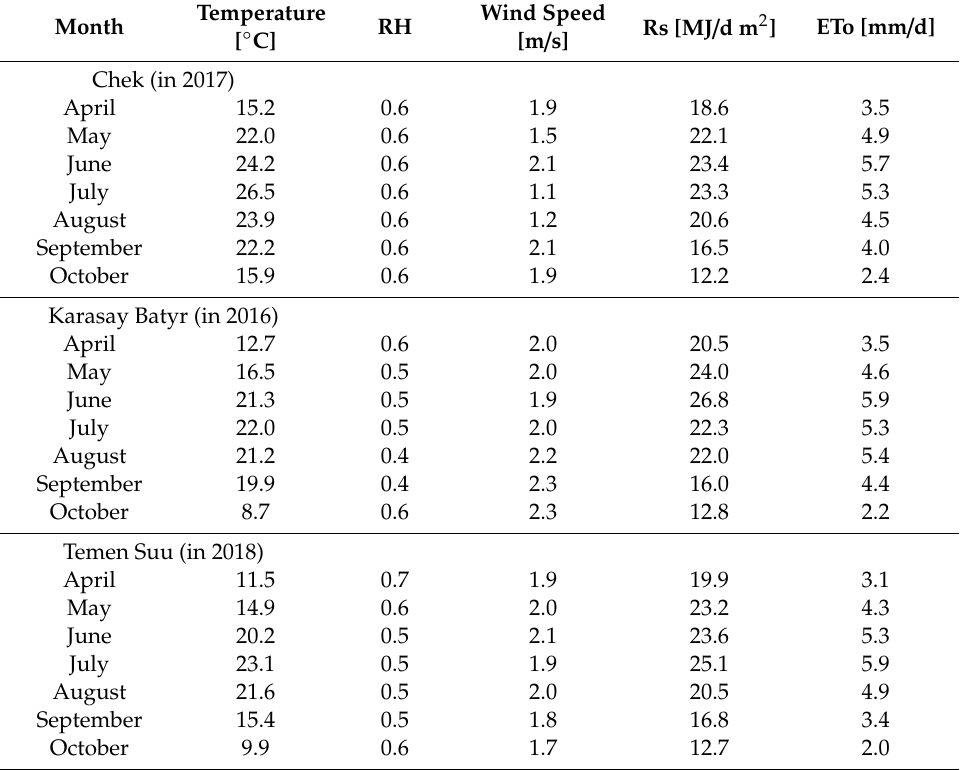
Table 2. Monthly averages of the temperature, air humidity (RH), wind speed, solar radiation (Rs), and reference evapotranspiration (ETo) for the three study sites of Chek, Karasay Batyr, and Temen Suu, as measured during this study.